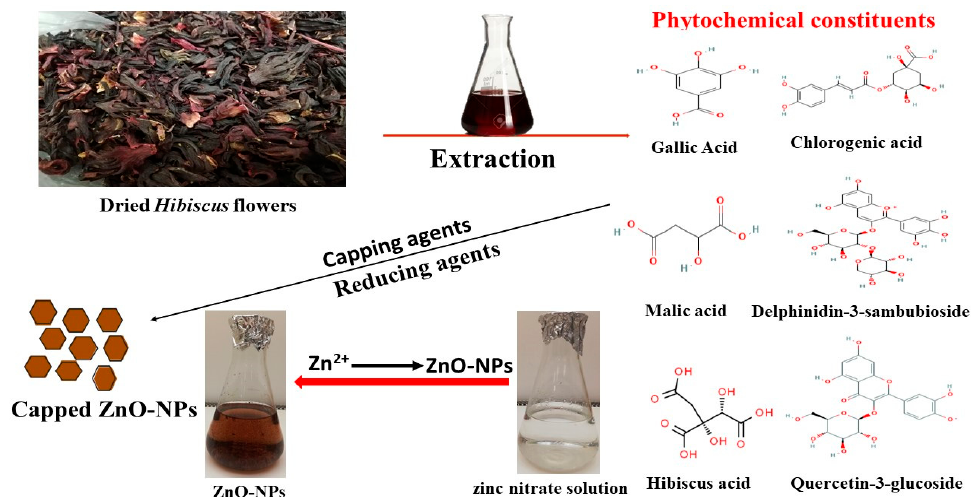
Figure 2. Diagrammatic illustration of ZnO-NPs biosynthesis.